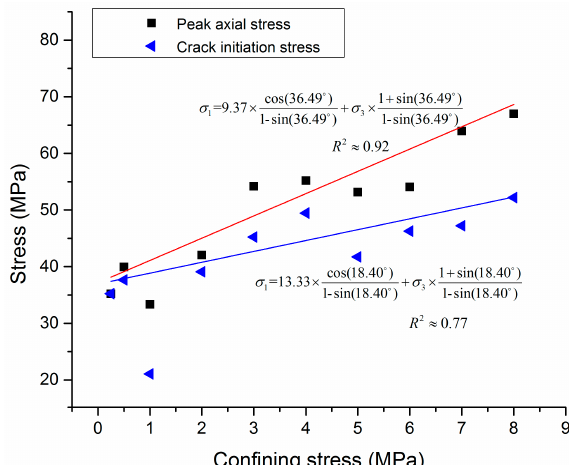
Figure 21. The increase in peak axial stress and crack initiation stress with the enhanced